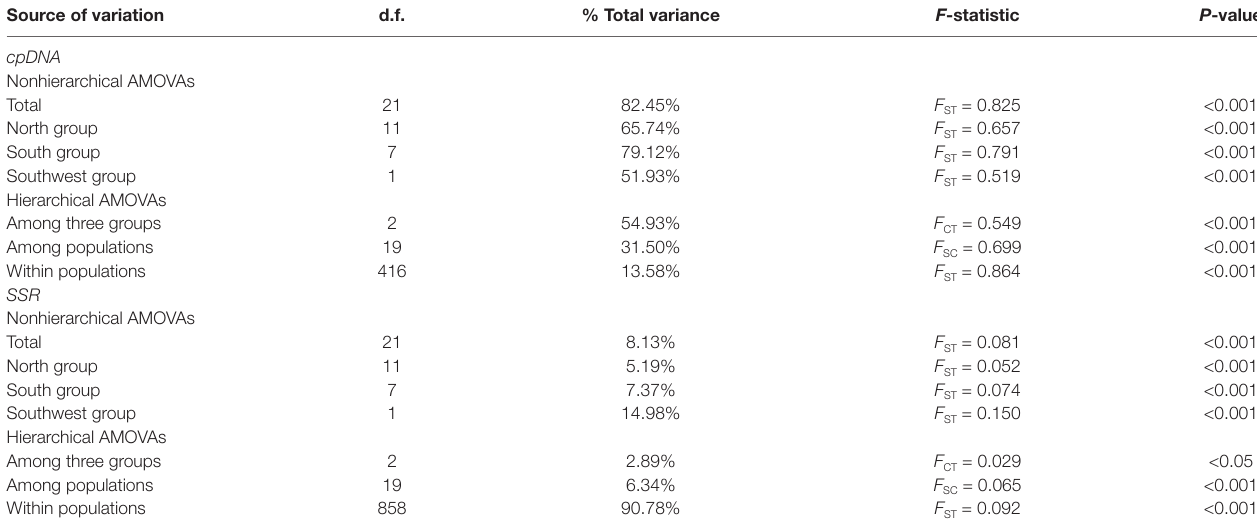
TABle 2 | Nonhierarchical and hierarchical AMOVAs for cpDNA and SSR variation surveyed in populations of Pterocarya stenoptera in China. source of variation